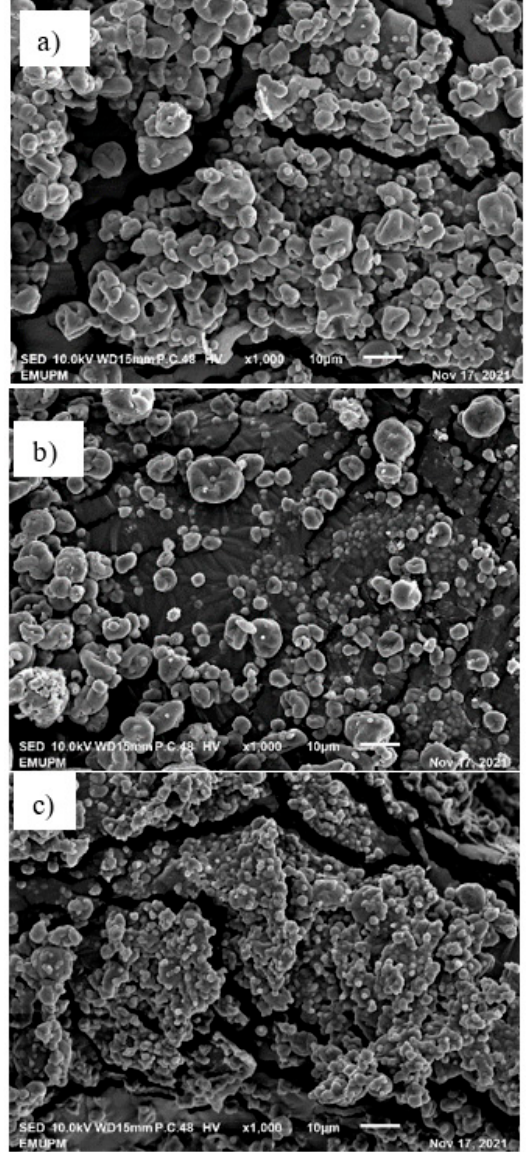
Figure 2. Change of the physical powder properties as the temperature changes from ( a ) 130 °C, ( b ) 160 °C, and ( c ) 200 °C.